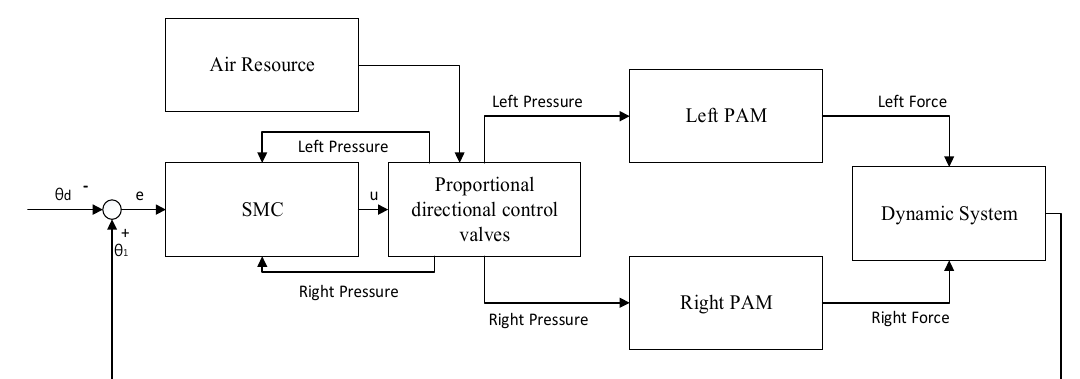
Figure 4. Overall view of system and SMC feedback controller system graph. The error of angle e = θ 1 − θ d : θ d is the trajectory of the tracking angle, and u is the control voltage command. The sliding plane for the high-order sliding-mode control (HOSMC) designed in this research is represented in Equation